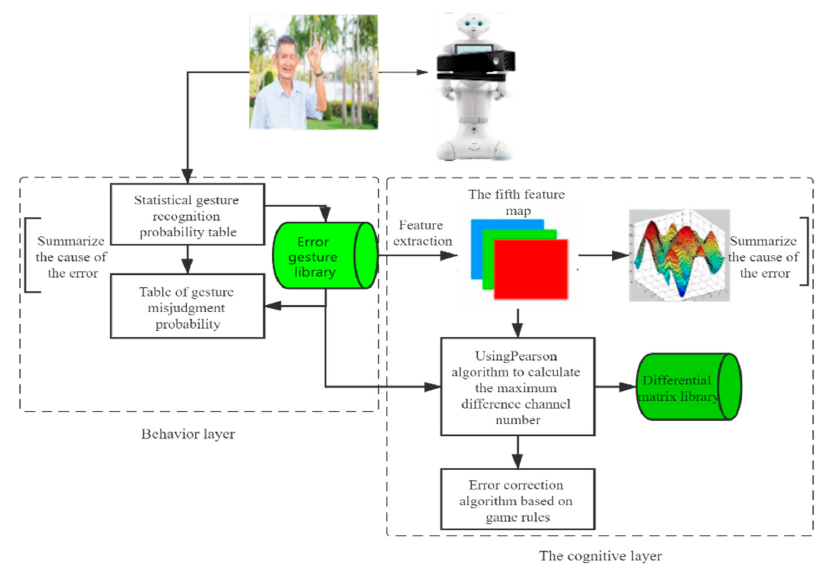
Figure 2. General framework of intelligent error correction algorithm.